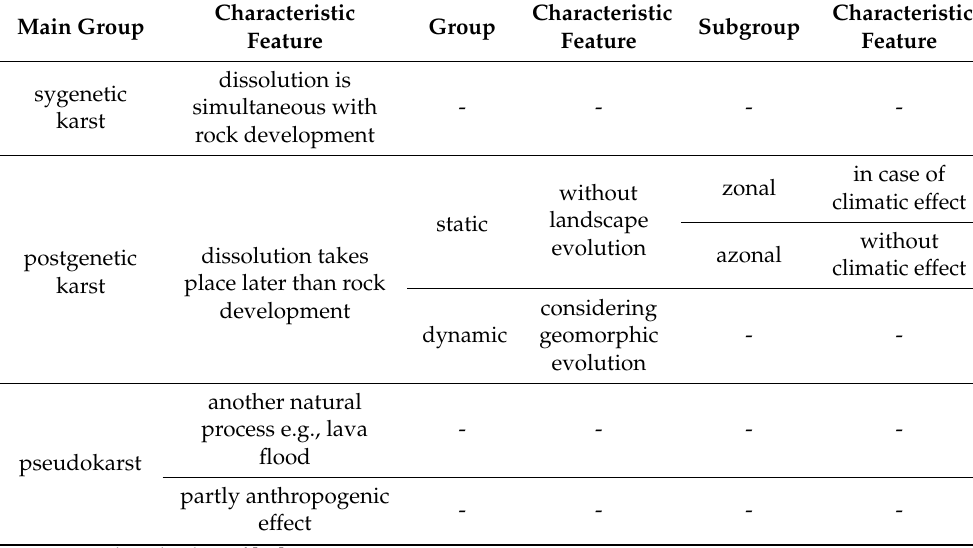
Table 1. Global, hierarchical system of karst